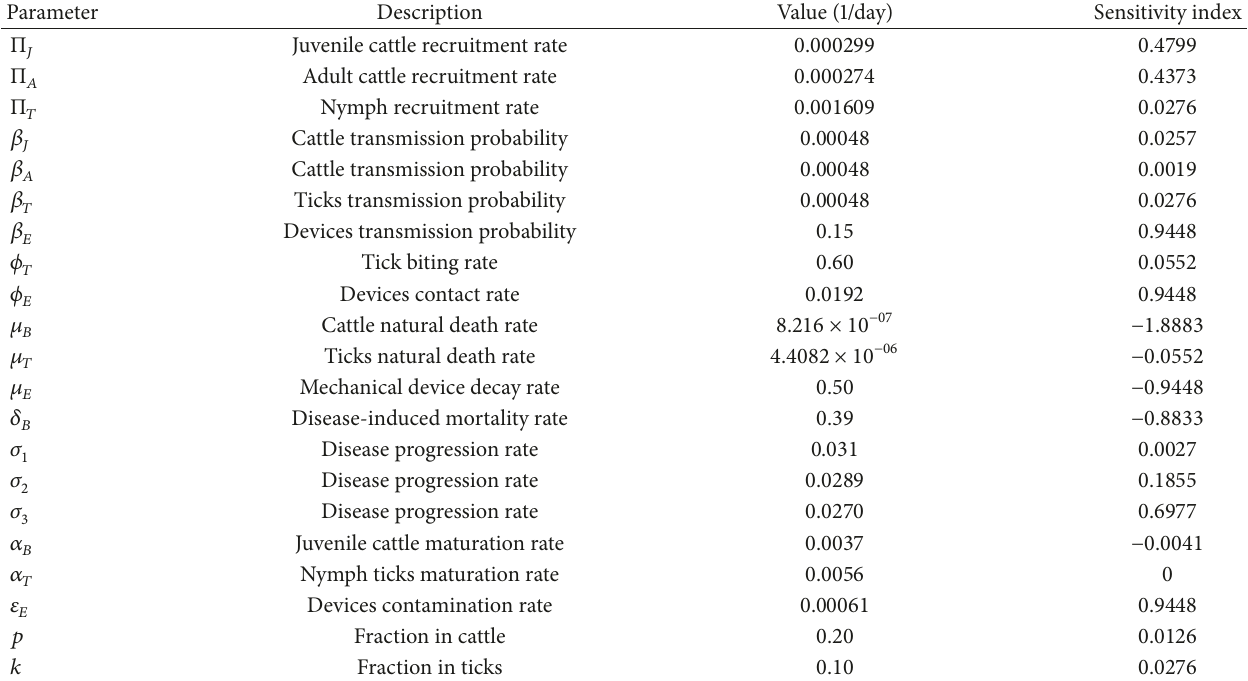
Table 2: Parameter values and sensitivity indices for each of the parameters for the bovine anaplasmosis model (12).